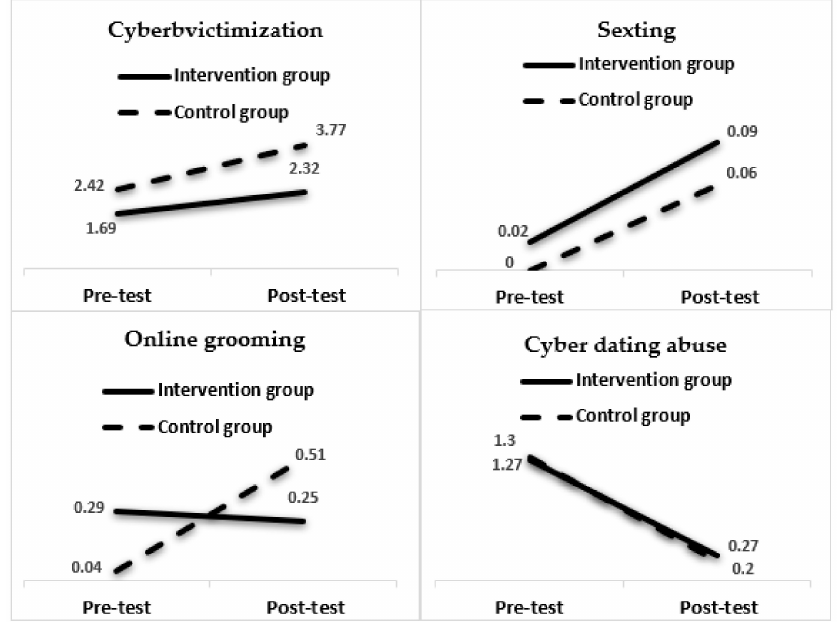
Figure 1. Means obtained by the groups (intervention and control) in online Internet